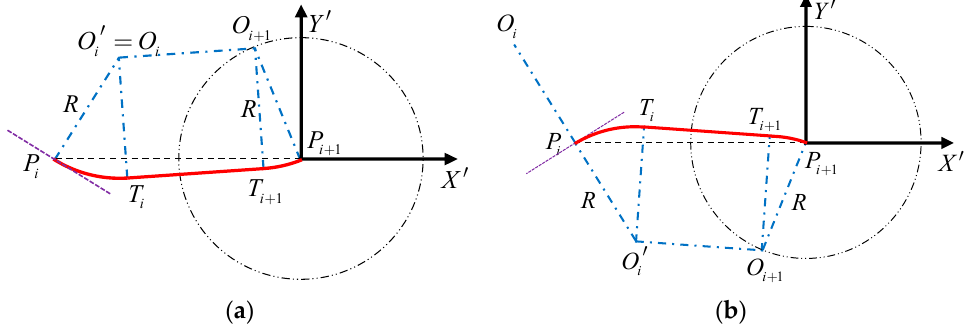
is less than the minimum i (cid:48) P i + 1